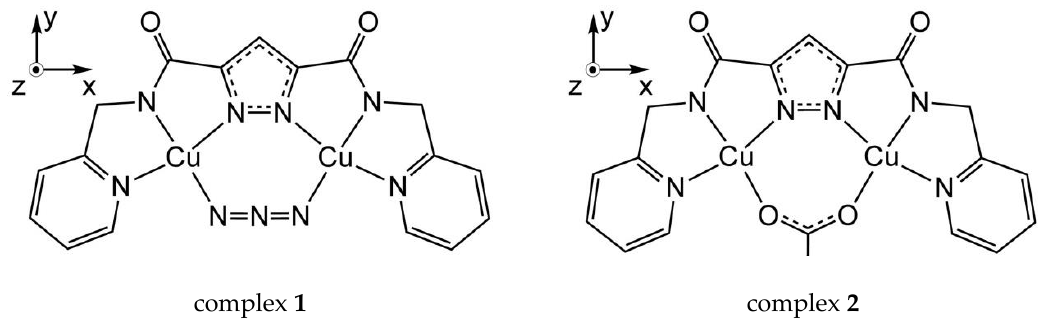
Figure 1. Dinuclear Cu(II) complexes bridged by azide (complex 1 ) and acetate (complex 2 )